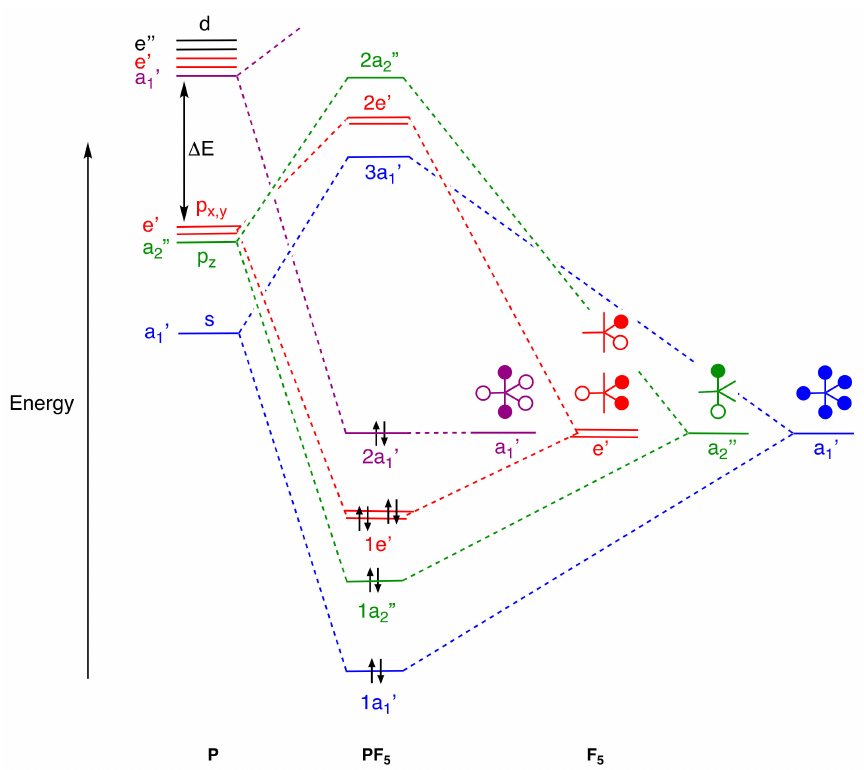
Figure 3. A simple, qualitative, σ -only MO energy-level diagram for PF 5 . Orbital interactions involving phosphorus 3s (a 1 ’), 3p z (a 2 ”), and 3p x,y (e’) orbitals are shown in blue, green, and red, respectively. The essentially non-bonding 2a 1 ’ orbital that has the correct symmetry to overlap with the phosphorus 3d z2 (a 1 ’) is shown in purple. No interactions are considered involving the phosphorus 3d orbitals of e’ and e”.